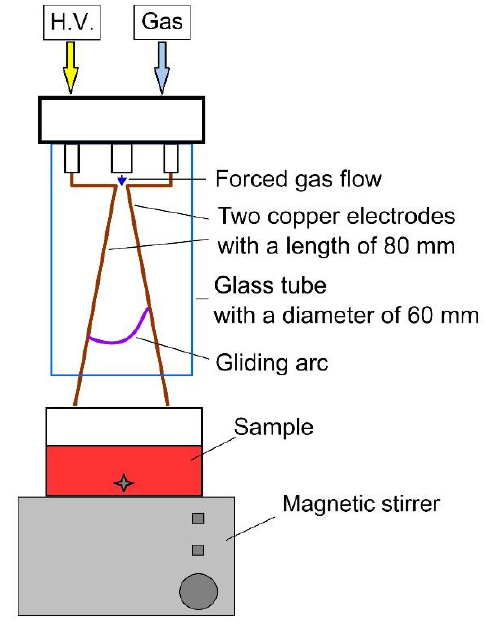
Figure 1. Experimental